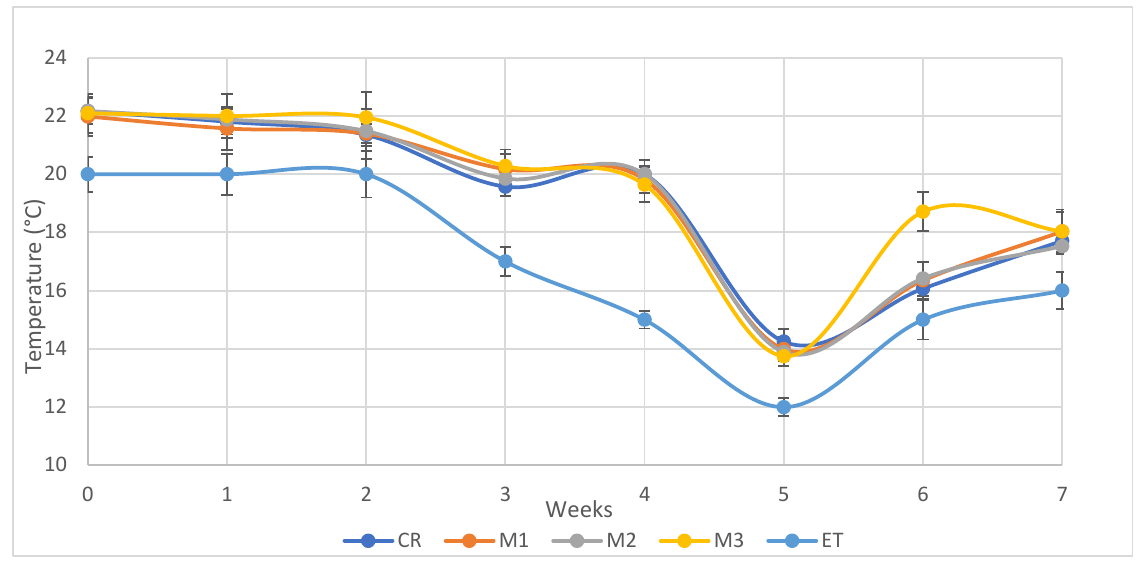
Figure 6. Enviromental Temperature (ET) and Mixtures Temperature (CR, M1, M2, M3) behavior during vermicomposting.